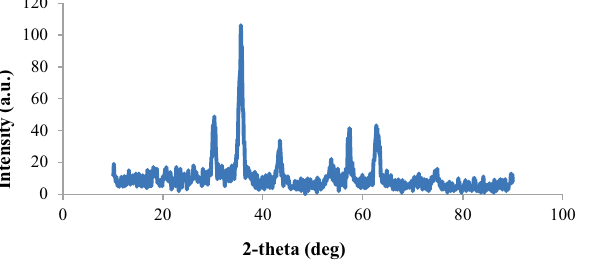
Figure 2. XRD analysis of MCS@PhTet@Cu(II).